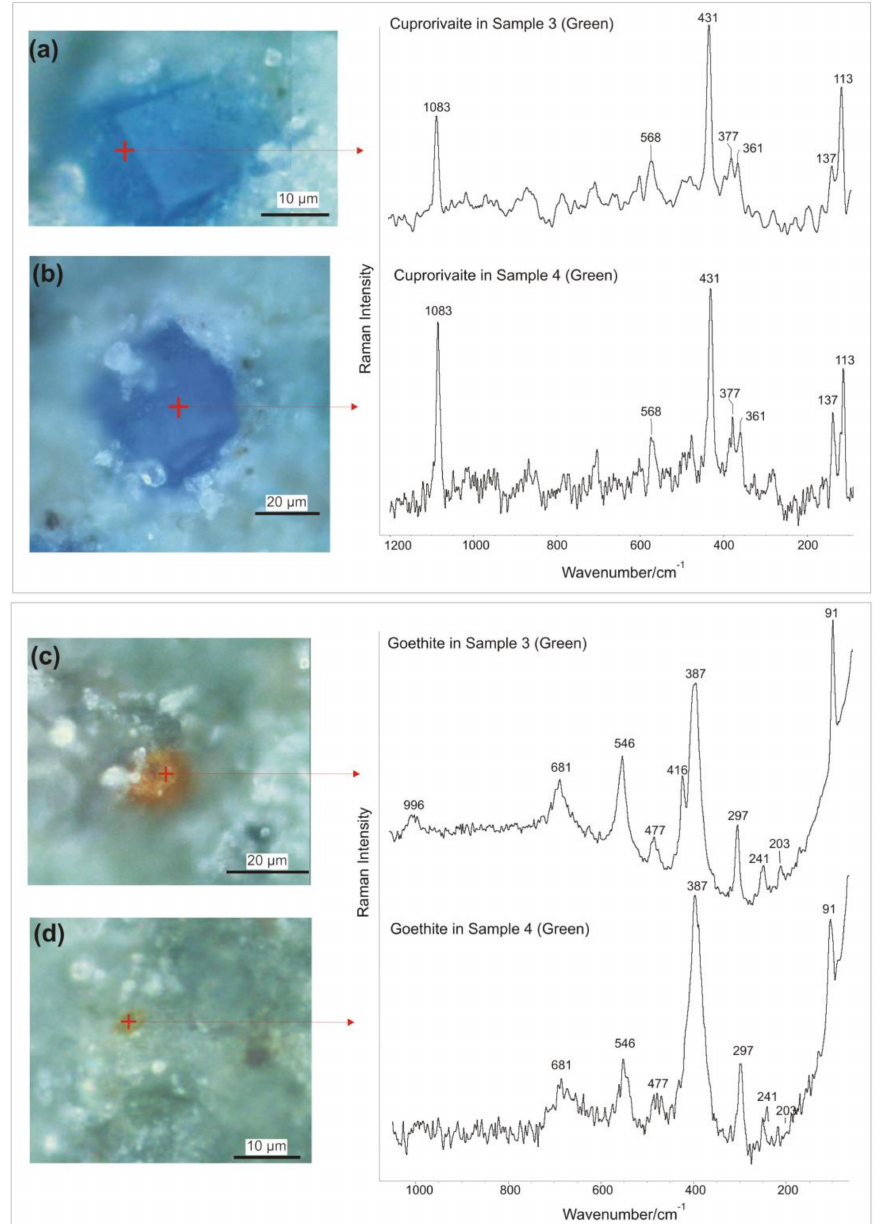
Figure 8. Optical microscope (OM) images of cuprorivaite under reflected light on the painted surfaces of Samples 3 ( a ) and 4 ( b ) with relative Raman spectra; OM images of goethite under reflected light on the painted surfaces of Samples 3 ( c ) and 4 ( d ) with relative Raman